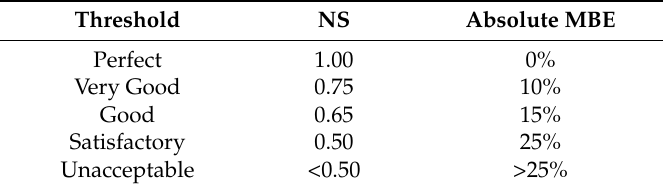
Table 3. Performance metrics used to evaluate model performance (modified from Moriasi et al.,